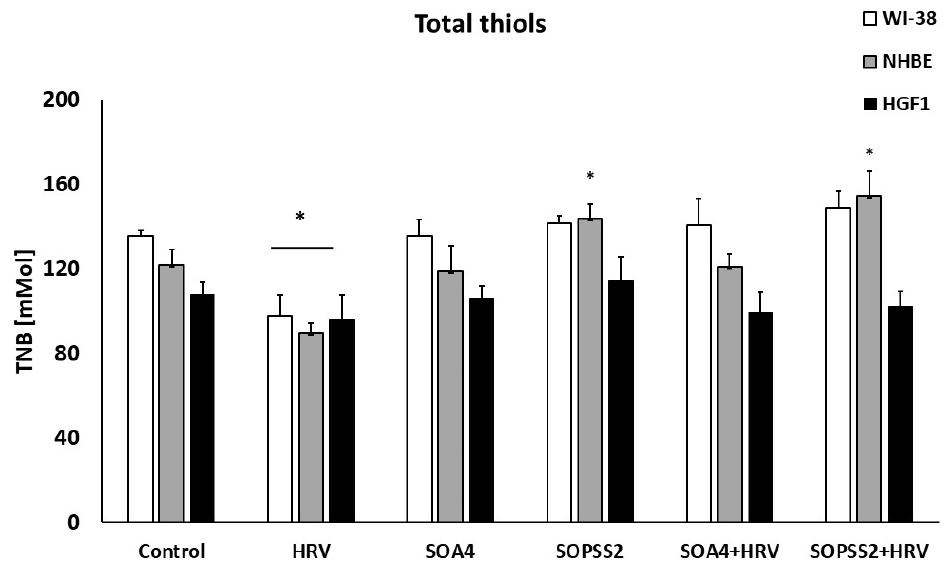
Figure 7. SOPSS2 induced the concentration of thiols in HRV infection conditions. Extracts from transformed (SOA4) and transgenic (SOPSS2) Senna obtusifolia hairy roots are given. Data presented as mean ± SEM, * p < 0.05.